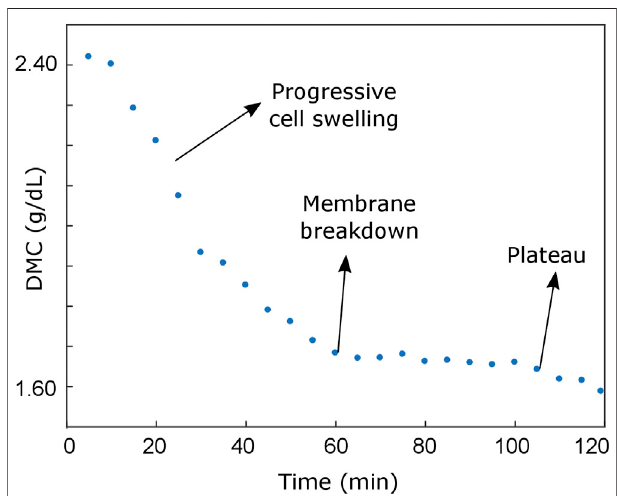
FIGURE 5 | Dry mass concentration evolution during the experiment, which enables the identi fi cation of two different cell behaviors during the necrosis:aninitialprogressivecellswelling(characterizedbyanapproximately lineardecreaseoftheaverageDMC)andaplateauregioncorresponding to the cell shrinking